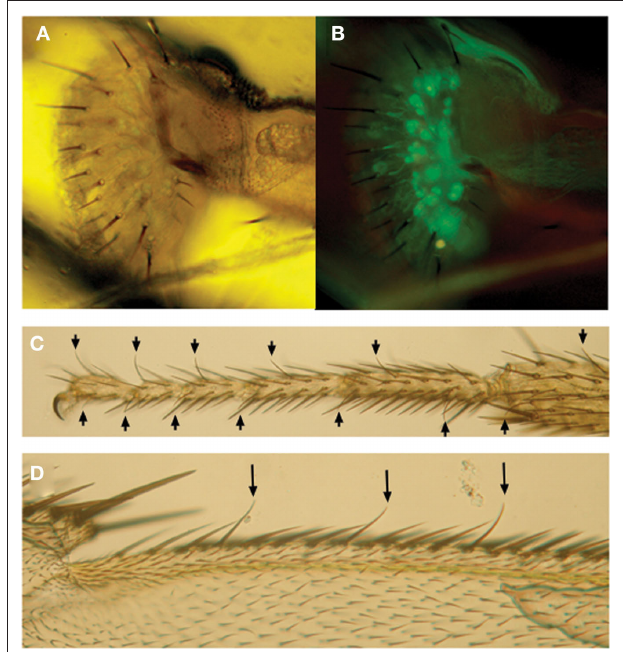
FiGuRe 5 | examples showing taste sensilla and labeled taste neurons in Drosophila . (A,B) Taste sensilla along the peripheral labella of a transformant fly expressing a cytoplasmic GFP marker protein driven by Gr5a promotor- Gal4 (Gr5a-Gal4/Gr5a-Gal4, UAS-2xEGFP/UAS-2xEGFP). Pictures were taken under microscope by transmission light (A) or by fluorescence microscope (B) . Arrows in (C) and (D) show other types of taste sensilla along the tarsal segments of the distal legs (C) and wing margins in (D)